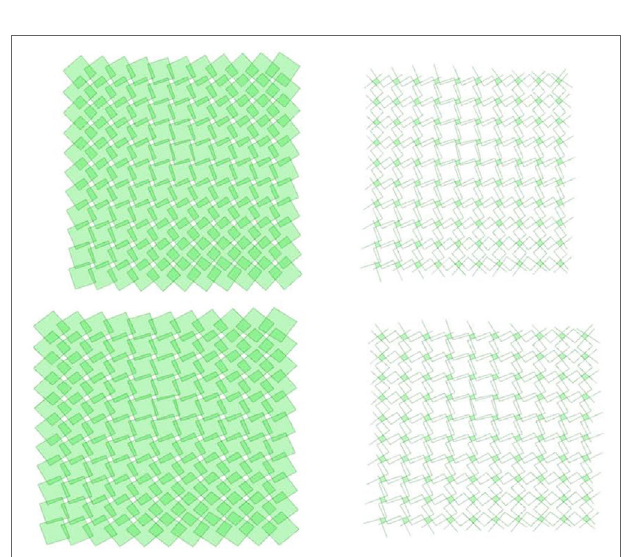
FIgURe 2 | DigDesFab15 “noHOME” research pavilion surface and subdivision